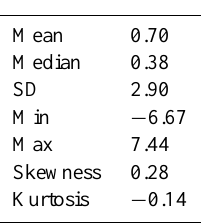
Table 3. Summary statistics of cross-section